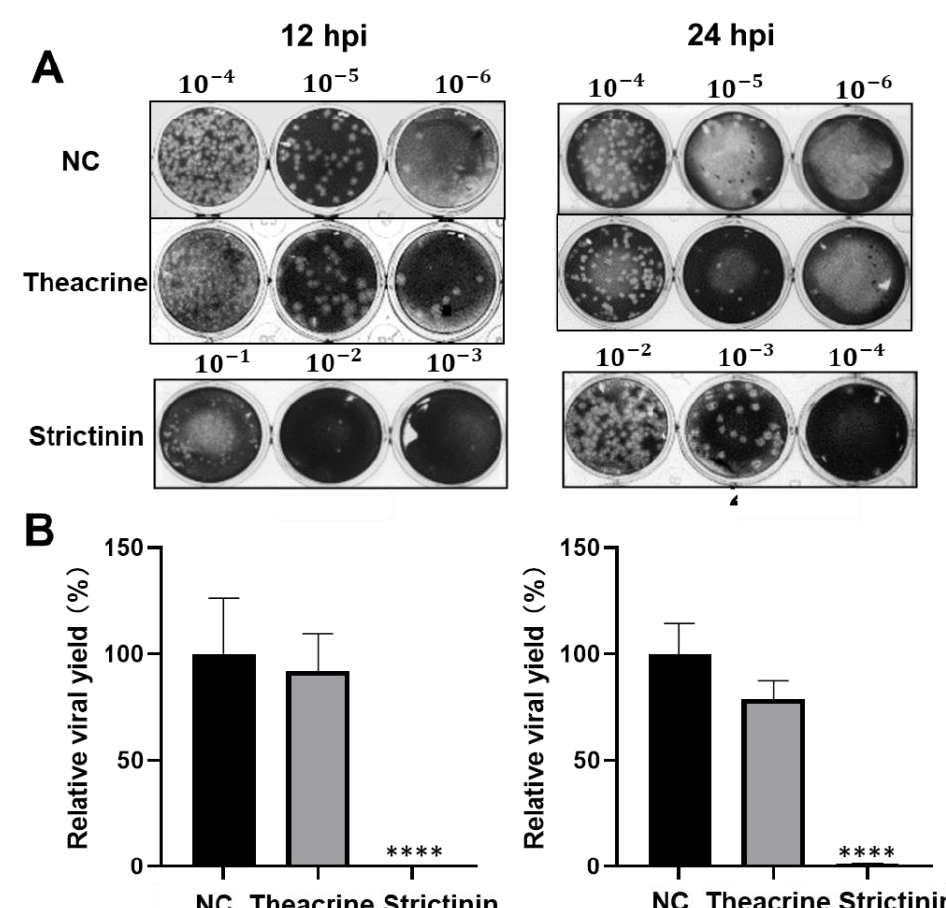
Figure 4. Effects of theacrine and strictinin on MHV progeny production. ( A ) MHV infection of mouse L cells was set at 0.01 MOI/well. The infection was accompanied by theacrine or strictinin of 100 µ M. At 12 and 24 hpi, progeny production was estimated by the plaque assay of serial dilutions (indicated on top of the plates) of supernatants collected from infected cells. NC was a negative control group with only MHV. ( B ) The relative viral yield was calculated by using the plaque number in the NC group as 100%. All data were presented as mean ± S.D. ( n = 3). **** p < 0.0001, indicating significant difference from NC, was analyzed using one-way ANOVA, followed by